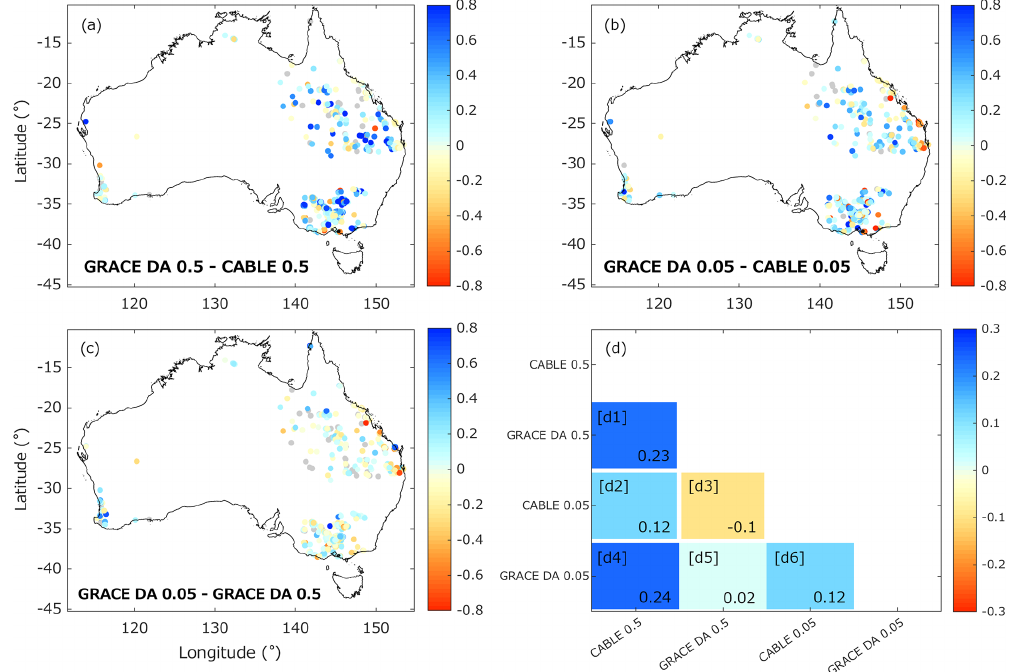
Figure 14. (a–c) Improvements or degradations in correlation values between case study simulations (Sect. 3.2.5) and in situ observations of GWS estimates. (a) GRACE DA 0.5 ◦ minus CABLE 0.5 ◦ , (b) GRACE DA 0.05 ◦ minus CABLE 0.05 ◦ , and (c) GRACE DA 0.05 ◦ minus GRACE DA 0.5 ◦ . The relative performance of each simulation is indicated with blue/red shading. Blue indicates that the first simulation is better than the second, and red indicates that the second is better than the first. Changes that are not significant at the 0.05 level are displayed in gray. (d) The average change in correlation value from each scenario is the vertically displayed case study minus the horizontally displayed case study (e.g., d1 represents GRACE DA 0.5 ◦ minus CABLE 0.5 ◦ and indicates that the former is significantly better than the latter).